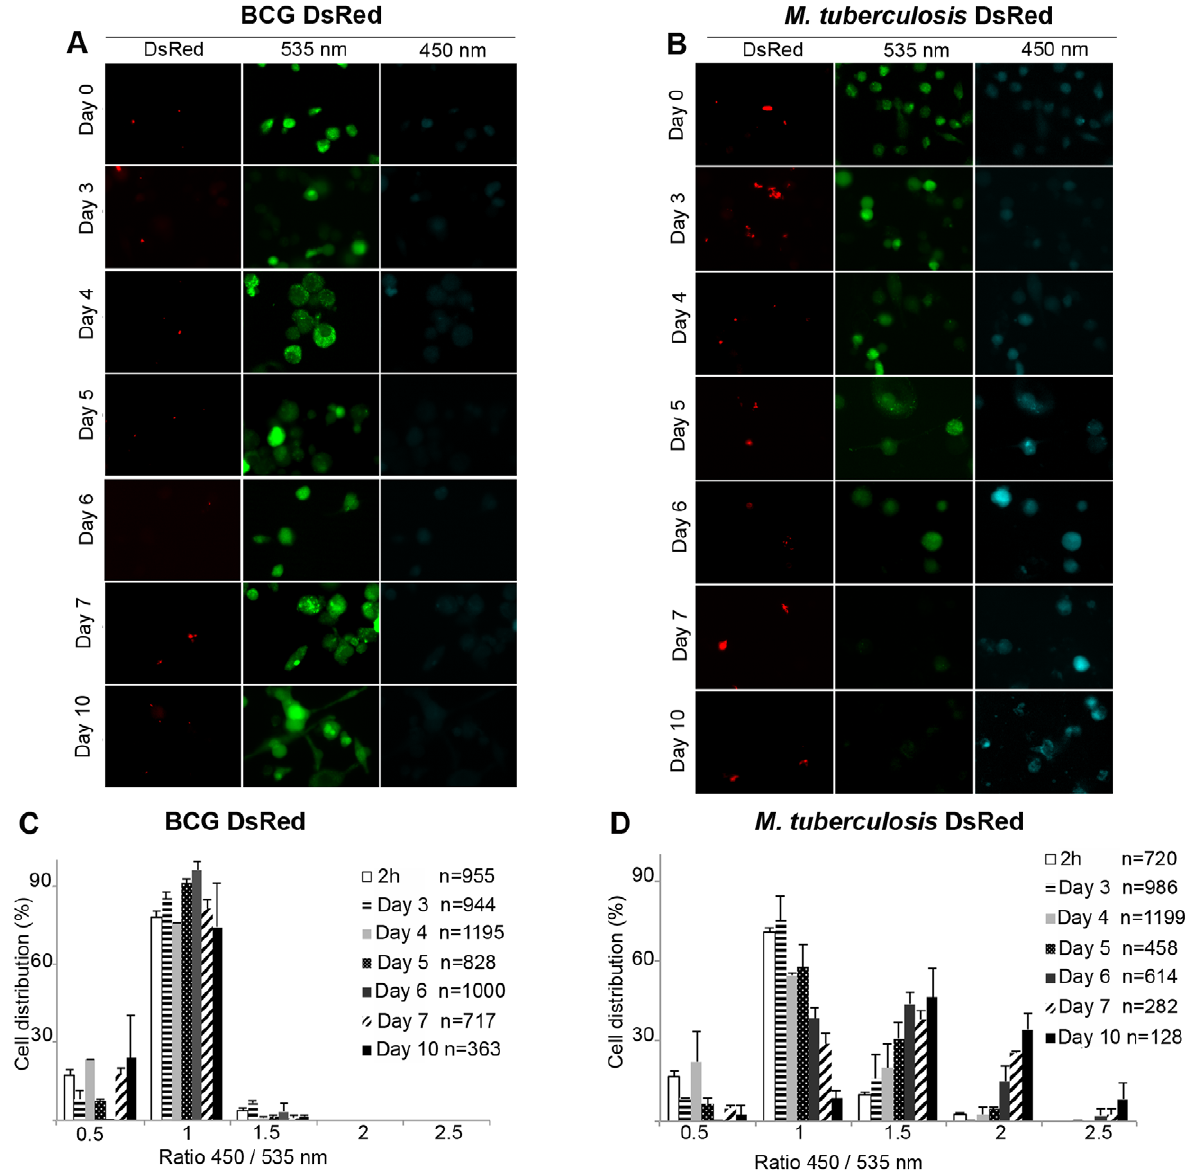
Figure 2. Unlike the attenuated BCG vaccine, virulent M.tuberculosis is able to induce phagosomal rupture in THP-1 macrophages. THP-1 cells were infected with BCG DsRed (A,C) or M. tuberculosis DsRed (B,D) at a MOI of 1 for the indicated time and then loaded with CCF-4 molecule for 2 h. After PFA fixation, cells were imaged using a fluorescence widefield microscope (Nikon Ti) with an 40X objective (A, B). Picture acquisition was achieved randomly and automatically for each condition on 49 fields in duplicates and further 450/535 nm intensity ratio measurements shown in panels C and D were obtained through analysis by a specialized algorithm using the Metamorph software. The plots are representative of 3 independent